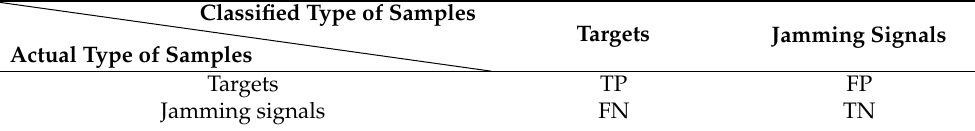
Table 3. Confusion matrix for target and interference signal classification and